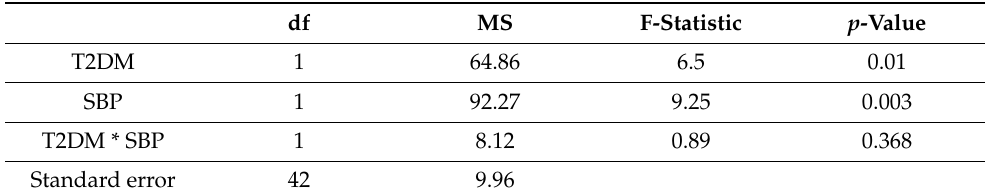
Table 3. Two-way analysis of variance of effects of diabetes, systolic blood pressure, and their interaction.